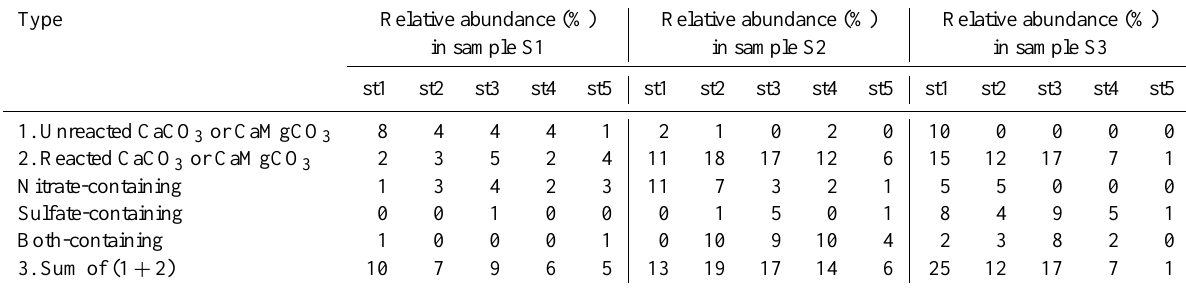
Table 4. Relative number abundance of unreacted and reacted CaCO 3 /CaMg(CO 3 ) 2 in samples S1–S3. Type Relative abundance (%) Relative abundance (%) Relative abundance (%) in sample S1 in sample S2 in sample S3